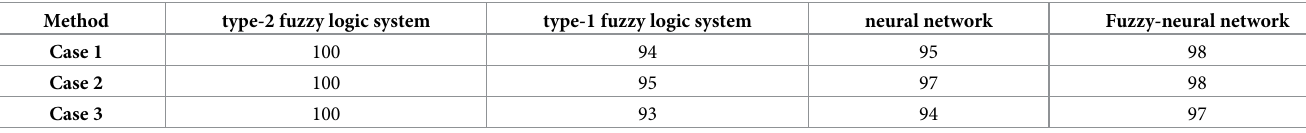
Table 6. Comparison of percentage of detection by different methods in scenario